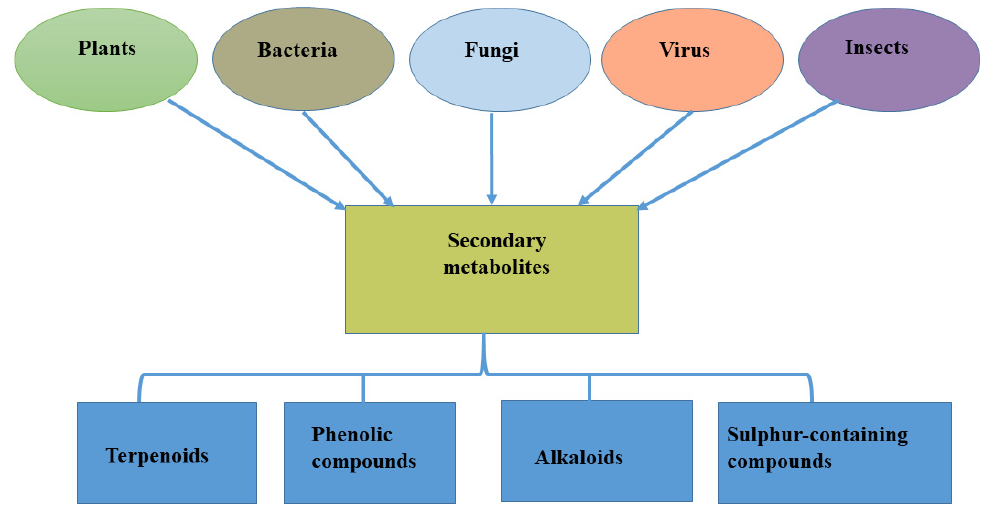
Figure 1. Sources of specialized metabolites and their major classifications.